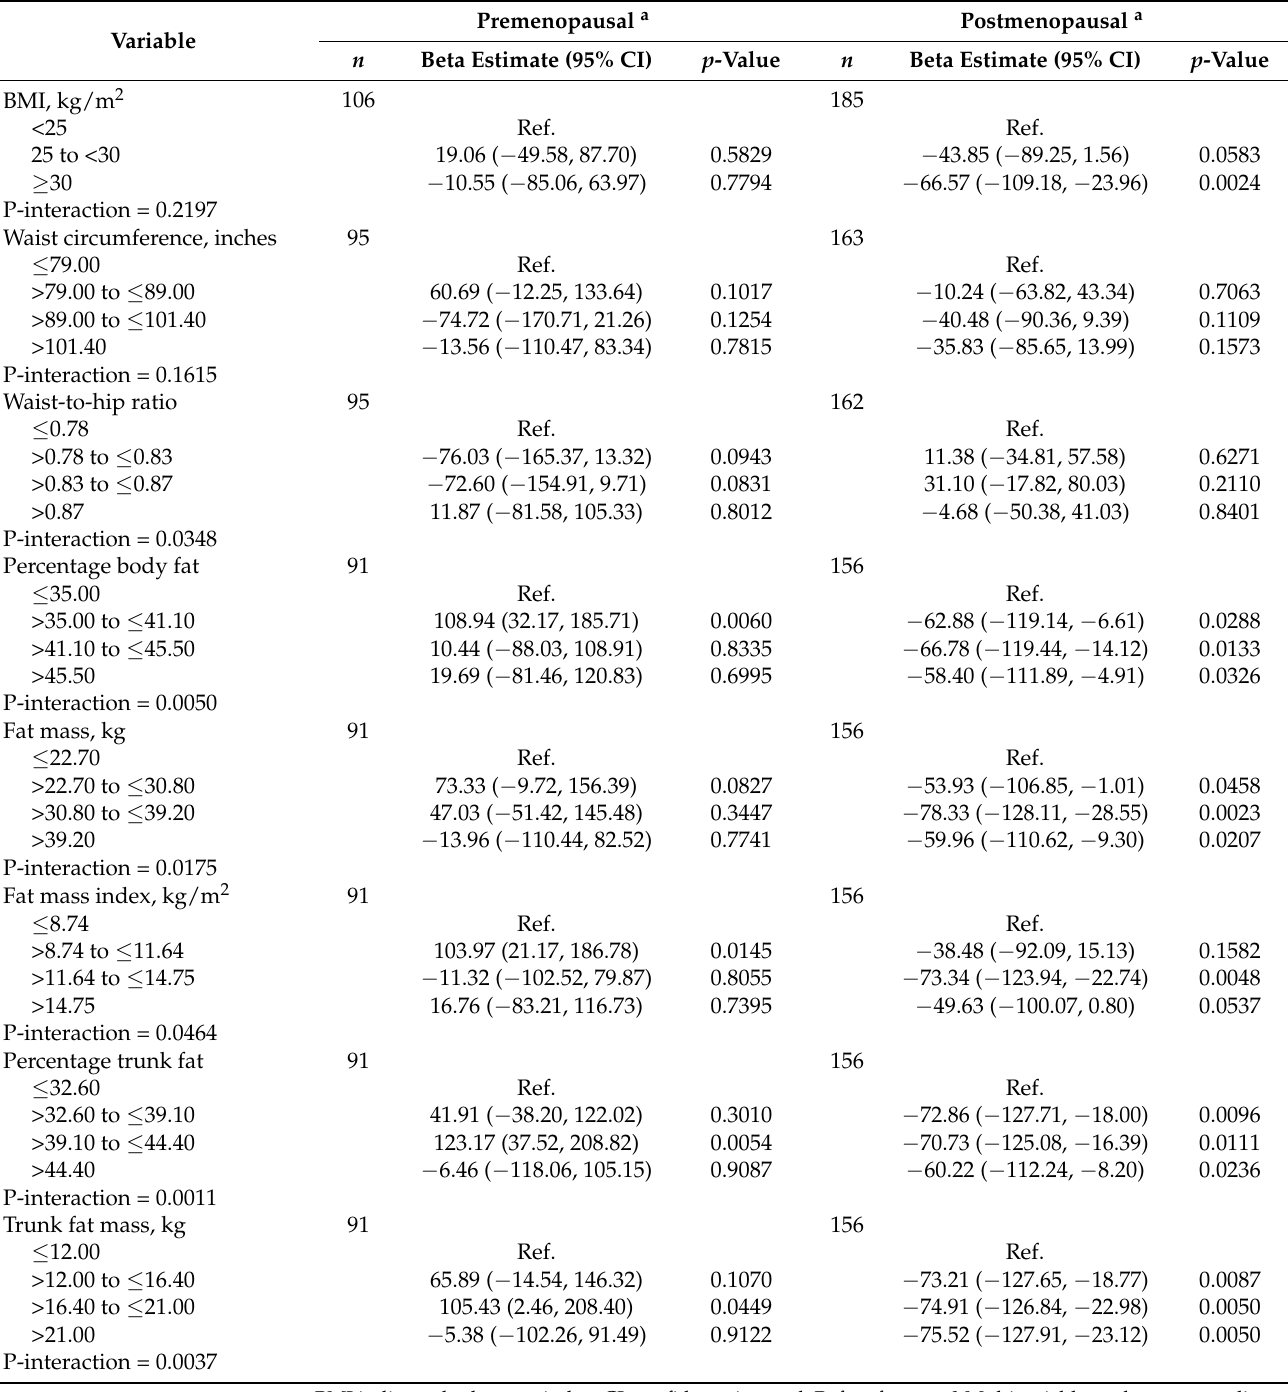
Table 5. Associations of body size and body composition with creatinine-corrected triclosan stratified by menopausal